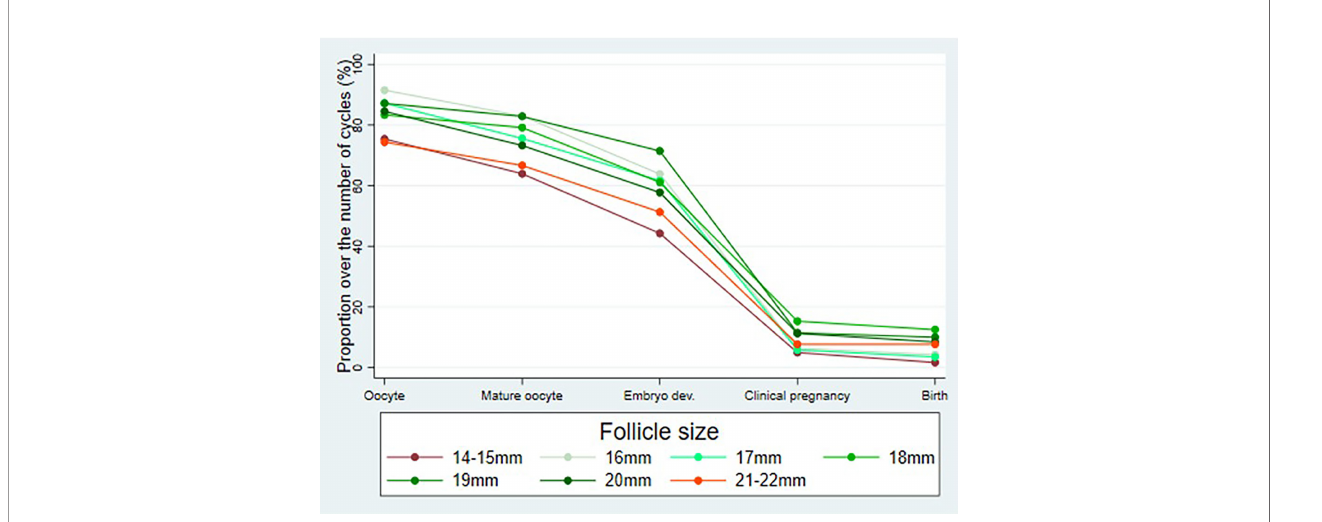
FIGURE 2 | Outcome parameters (percentage of cycles with aspirated oocytes, mature oocytes (metaphase II), embryos on day 2 after follicle aspiration as well as clinical pregnancies and live births in relation to follicle size (day 0) per follicle aspiration.